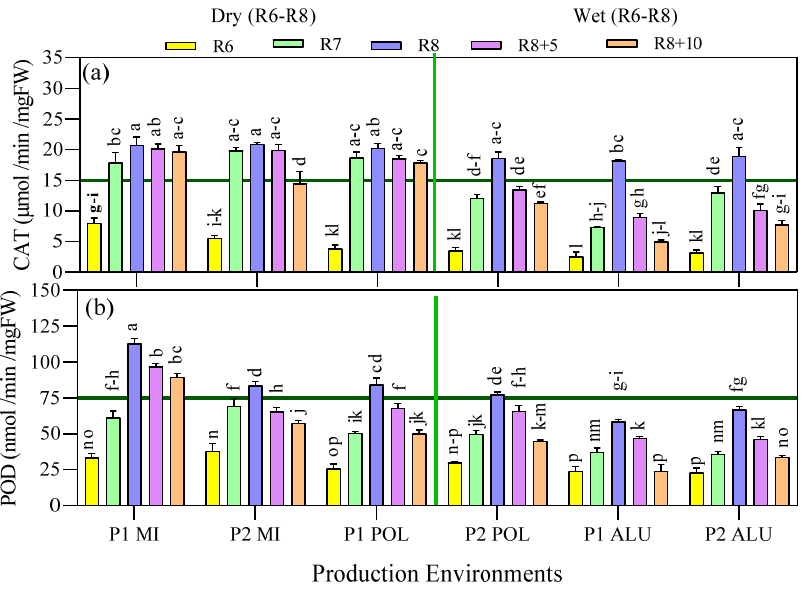
Figure 6. (a) Catalase activity (CAT) and (b) peroxidase activity (POD) as affected by the interaction between the production environment and harvesting maturity stages. Data are presented as mean ± SE of three replicates. Means followed by the same letters do not differ significantly using Ls means at p < 0.05. Wet and dry were grouped based on the late reproductive stage environments condition.